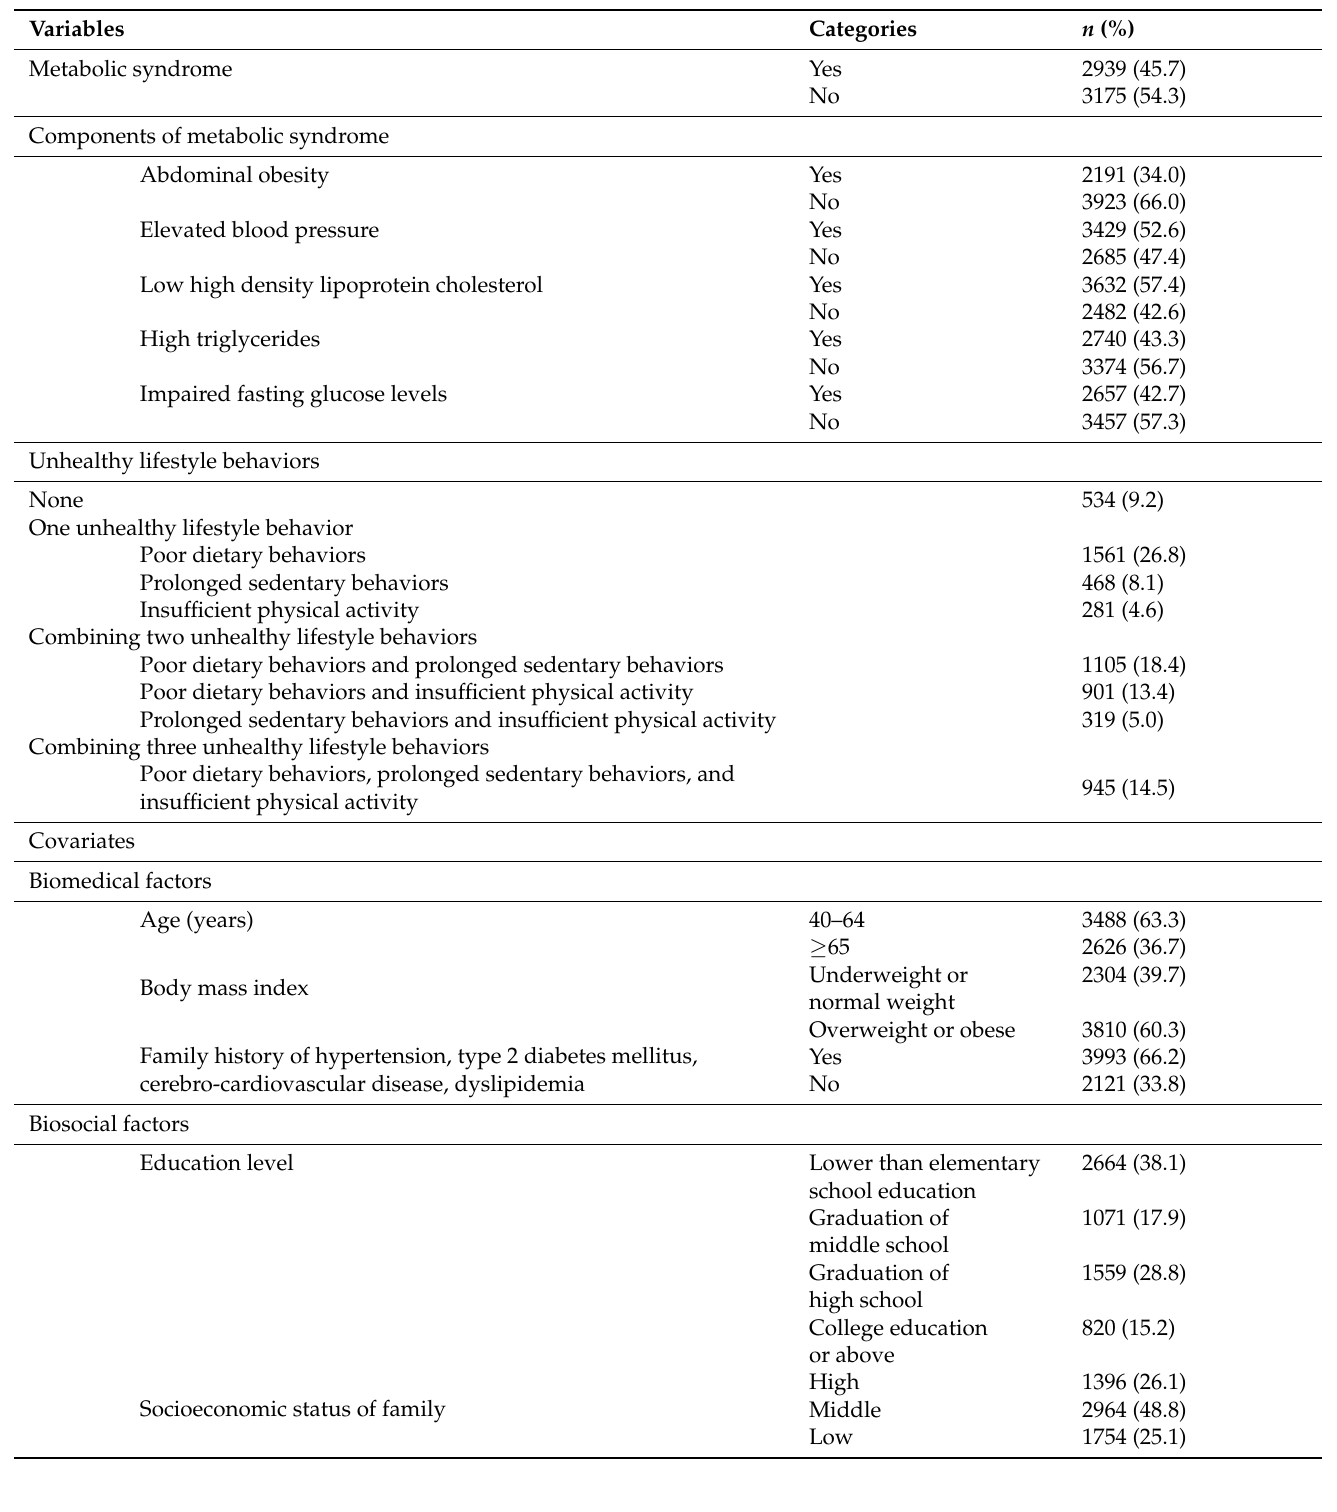
Table 1. Characteristics of Metabolic Syndrome, Unhealthy Lifestyle Behaviors, and Covariates among Participants ( N =